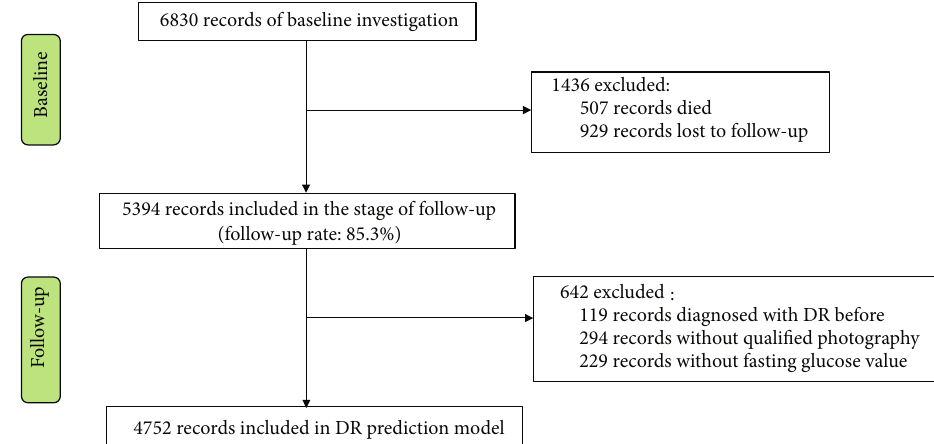
Figure 1: Flow chart of subject